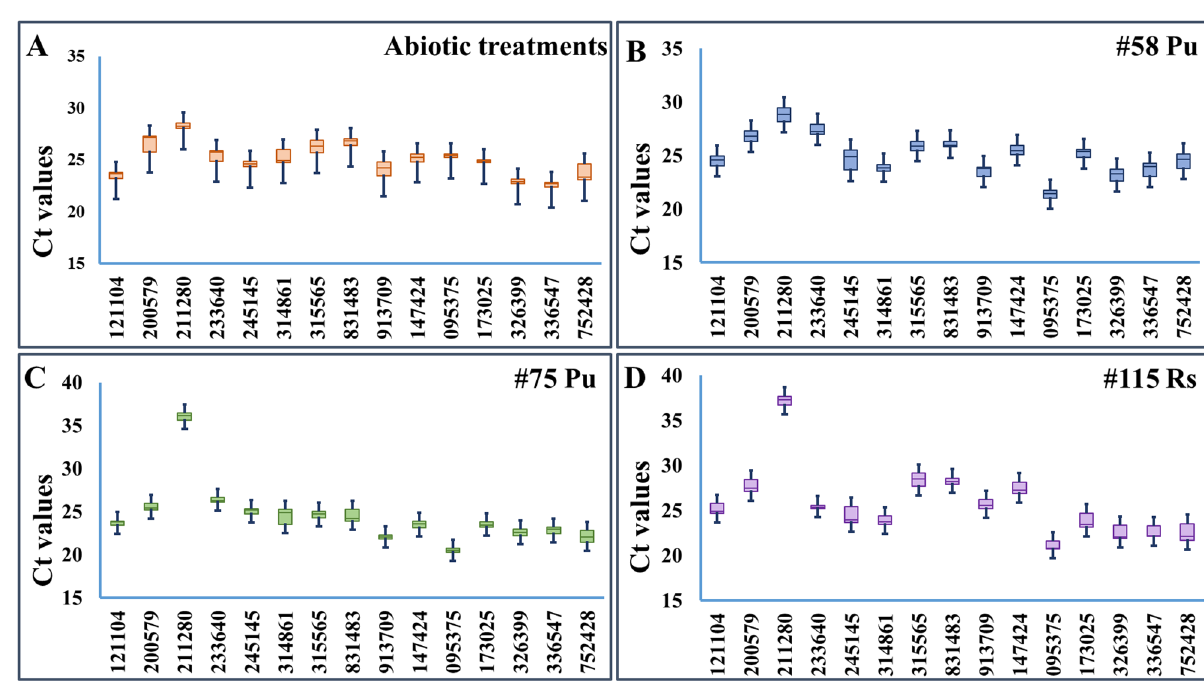
Fig 1. Cycle threshold (Ct) values of the fifteen tested genes across all samples. (A) Abiotic stresses treated root tissues of cultivar ‘Gala’; (B) P . ultimum infected #58 roots; (C) P . ultimum infected #75 roots; (D) R . solani infected #115 roots. For each box, the upper and lower edgesindicate the 25th and 75th percentiles, while whisker caps representthe maximum and minimum values. The line across the box depicts the median.